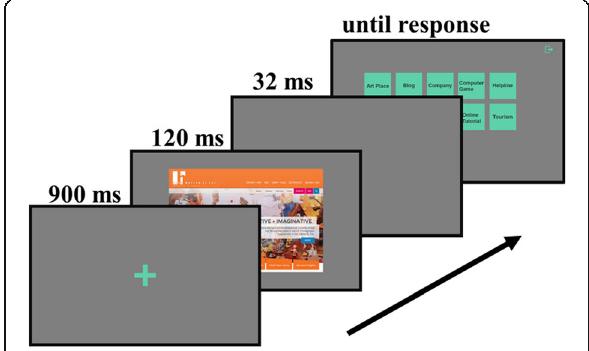
Fig. 2 Schematic of the gist experiment. Participants were instructed to fixate on a cross in the center of the screen. A screenshot appeared for 120 ms, then was replaced with a response screen after a short blank screen. Participants had unlimited time to make their response, then the next trial